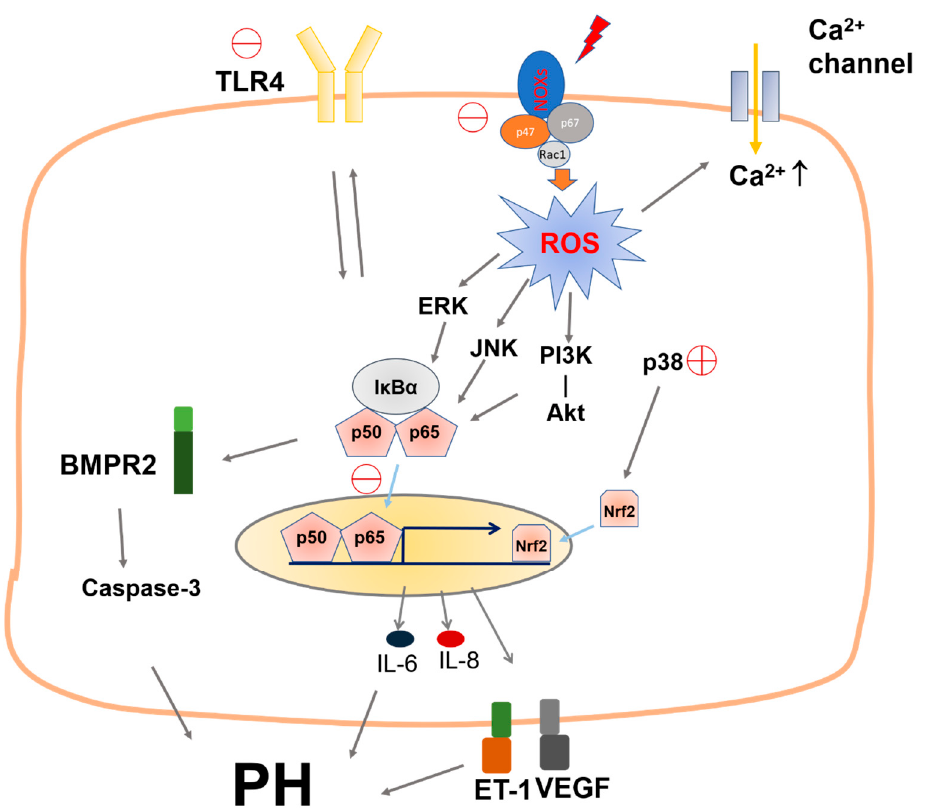
Figure 10. Schematic illustration of the mechanisms for the beneficial effects of ANDRO on PH. AN- DRO inhibits ROS generation by decreasing NOX2, NOX4 and p47phox expression and suppresses the TLR4/NF- κ B pathway by inhibiting the protein expression of TLR4 and the translocation of NF-kb. ANDRO upregulates BMPR2 expression and inhibits cytokines like IL-6 and IL-8 expression, and ET-1 and VEGF protein expression. ANDRO also inhibits ROS generation and [Ca 2+ ] i elevation and the activation of JNK-/ERK-MAPKs. Interestingly, ANDRO stimulates p38-MAPK which is suppressed during PH. All these events contribute to the therapeutic effects of ANDRO.